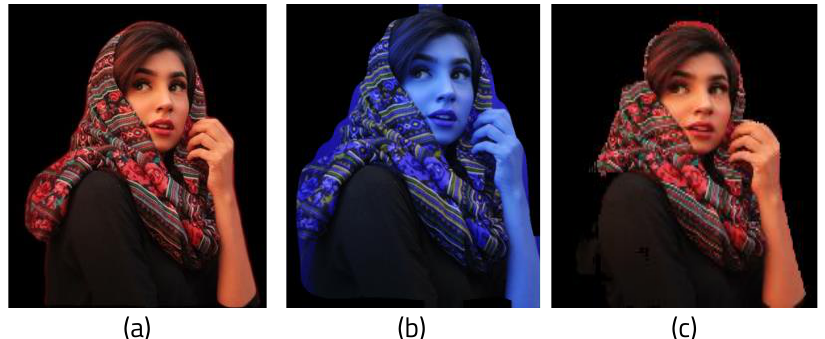
Figure 5. Results of segmentation algorithms: ( a ) Pytorch, ( b ) Mask RCNN, ( c ) ENet.